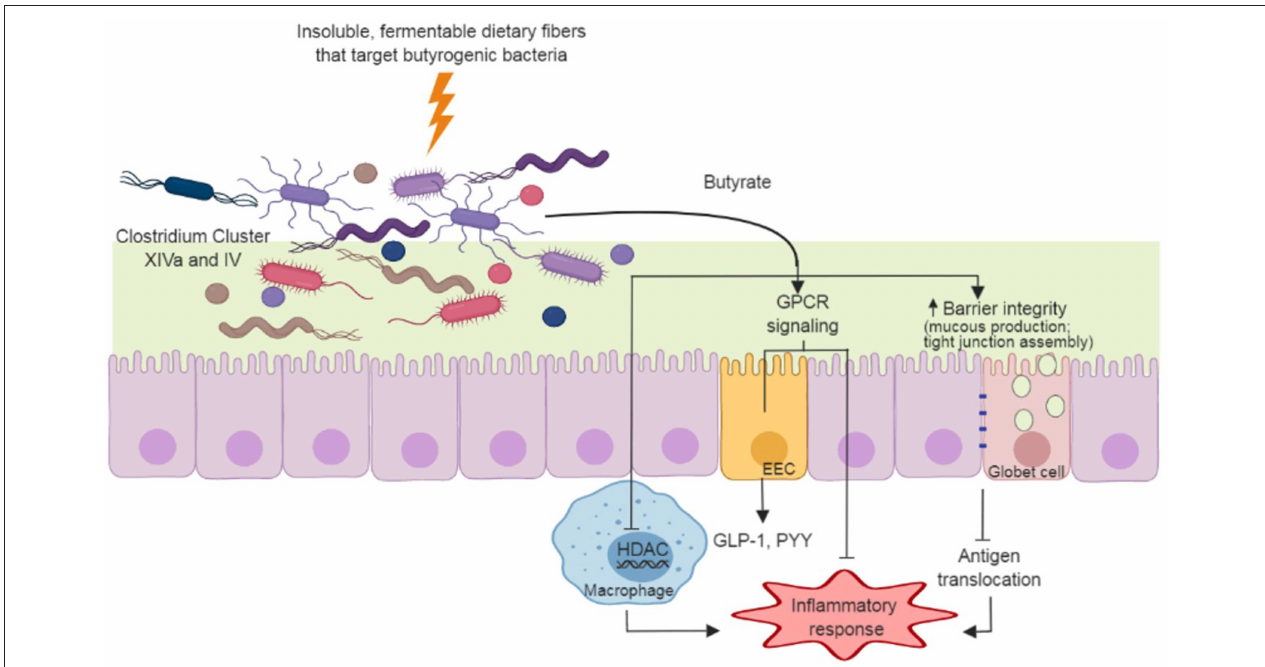
FIGURE 1 | Dietary fiber approach to increase gut-produced butyrate and pathways that have potential benefits to Parkinson’s Disease. Insoluble dietary fibers with specific chemical structures are fermented by butyrate producers in the gut (e.g., Clostridium Cluster XIVa and IV species). The butyrate produced during fermentation supports gut barrier function through the stimulation of mucus production and tight junction assemblies, and minimizing antigen translocation and inflammation. Butyrate also regulates inflammatory pathways through G protein-coupled receptors (GPCR) in enterocytes and through inhibition of histone deacetylase (HDAC) in macrophages. GPCR signaling in enteroendocrine cells (EEC) induce secretion of hormones (e.g., glucagon-like peptide-1 [GLP-1] and peptide YY[PYY]) that act in many organs, including the